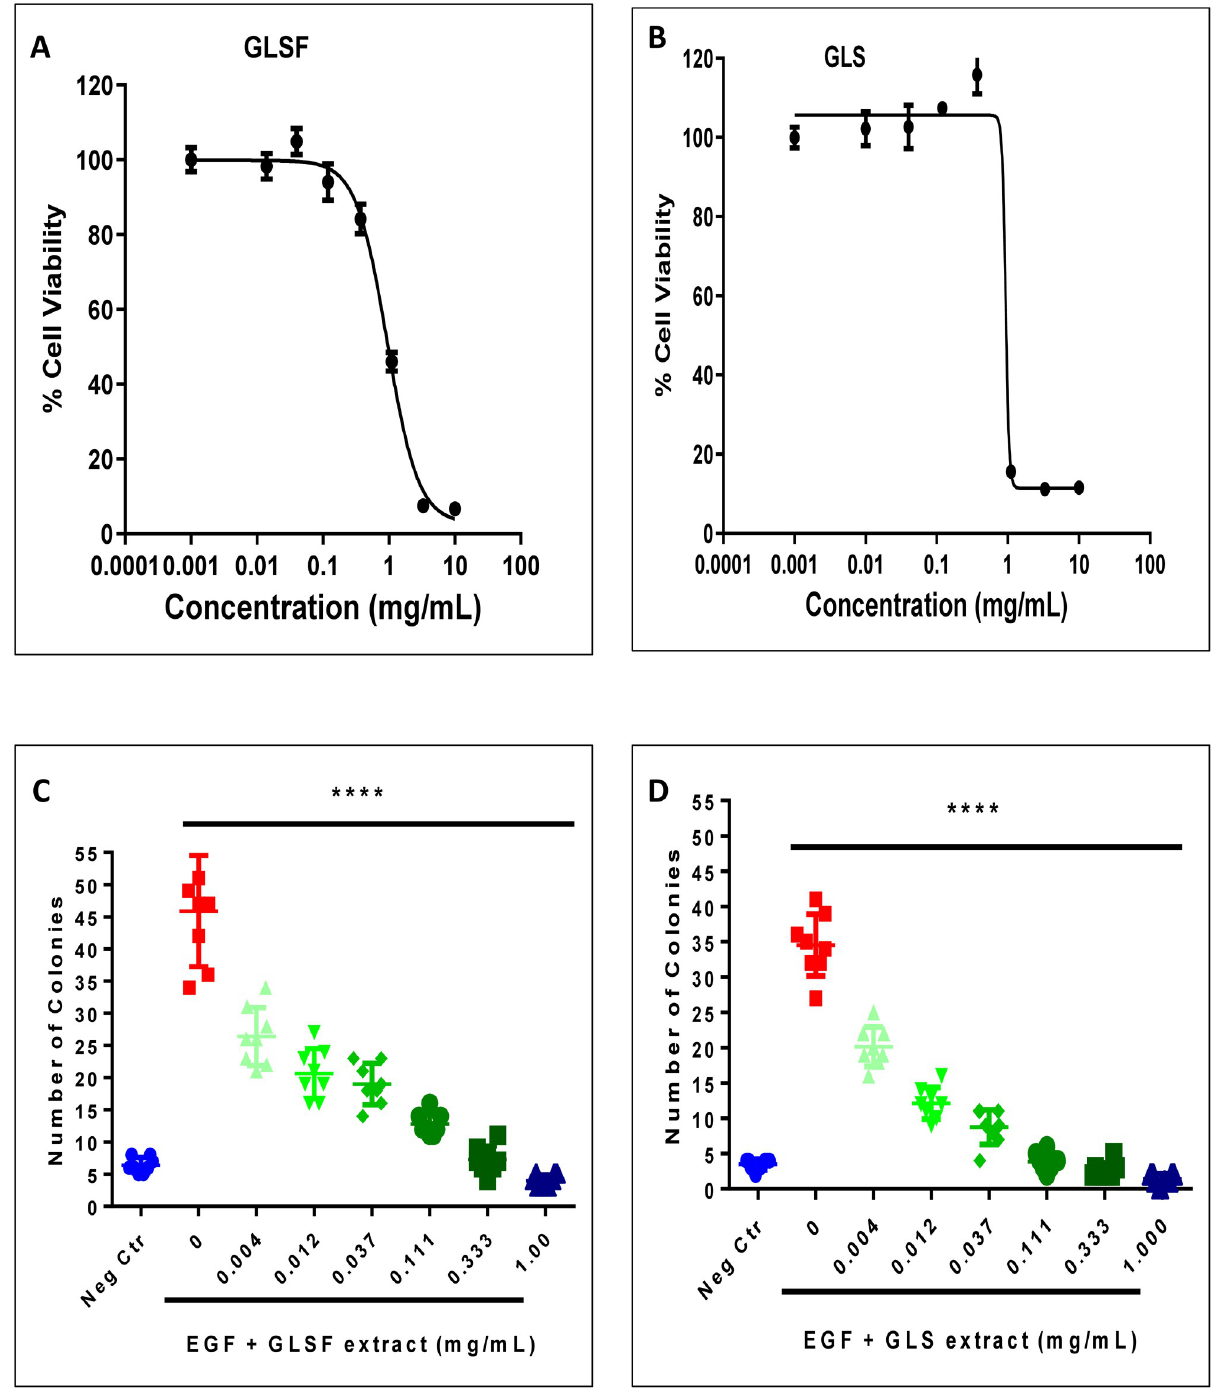
Fig 1. Effects of GLSF and GLS gastrointestinal juice extracts on cell viability and transformation in JB6 P+ cell line. (A) GLSF extract was examined for cytotoxicity and growth inhibitory activity on monolayer culture of JB6 P+ cells using SRB assay. Estimated IC 50 value was 1.0 mg/mL. (B) GLS extract was examined for cytotoxicity and growth inhibitory activity on monolayer culture of JB6 P+ cells using SRB assay. Estimated IC 50 value was 0.75 mg/mL. (C) GLSF extract at various concentrations was examined for its anti-transformation activity, i.e., suppressing cell transformation of JB6 induced by EGF (10 ng/mL) using soft agar assay. Estimated IC 50 value was 0.0085 mg/mL. (D) GLS extract at various concentrations was examined for its anti-transformation activity on soft agar. Estimated IC 50 value was 0.0075 mg/mL. ���� : P < 0.0001 as determined by ANOVA and Dunnett’s post hoc test.